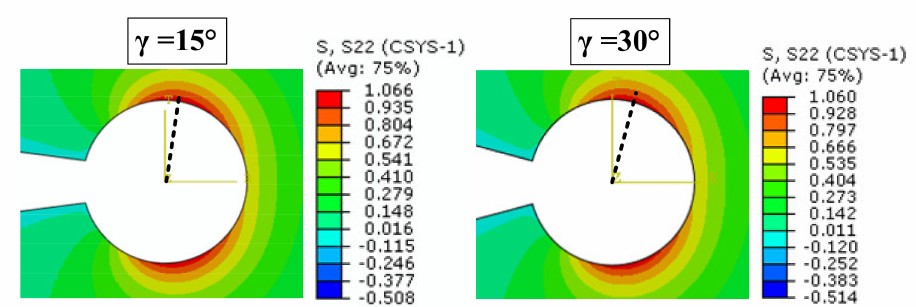
Figure 5. TS contours around VO-notches for DCB 2 model with various notch opening angles ( ρ = 2.5 mm).